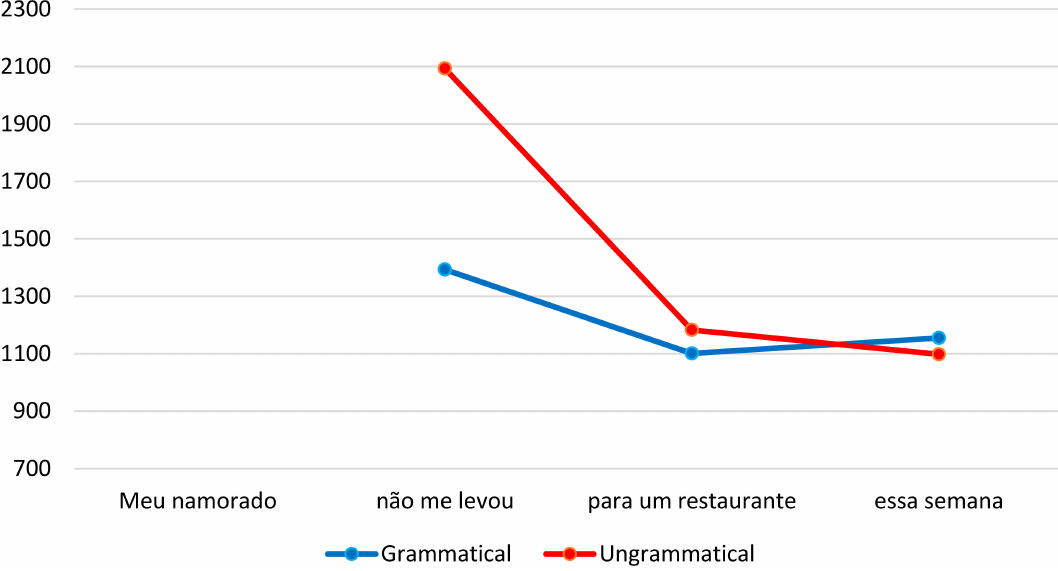
Figure 2. L1 Spanish speakers in the proclisis